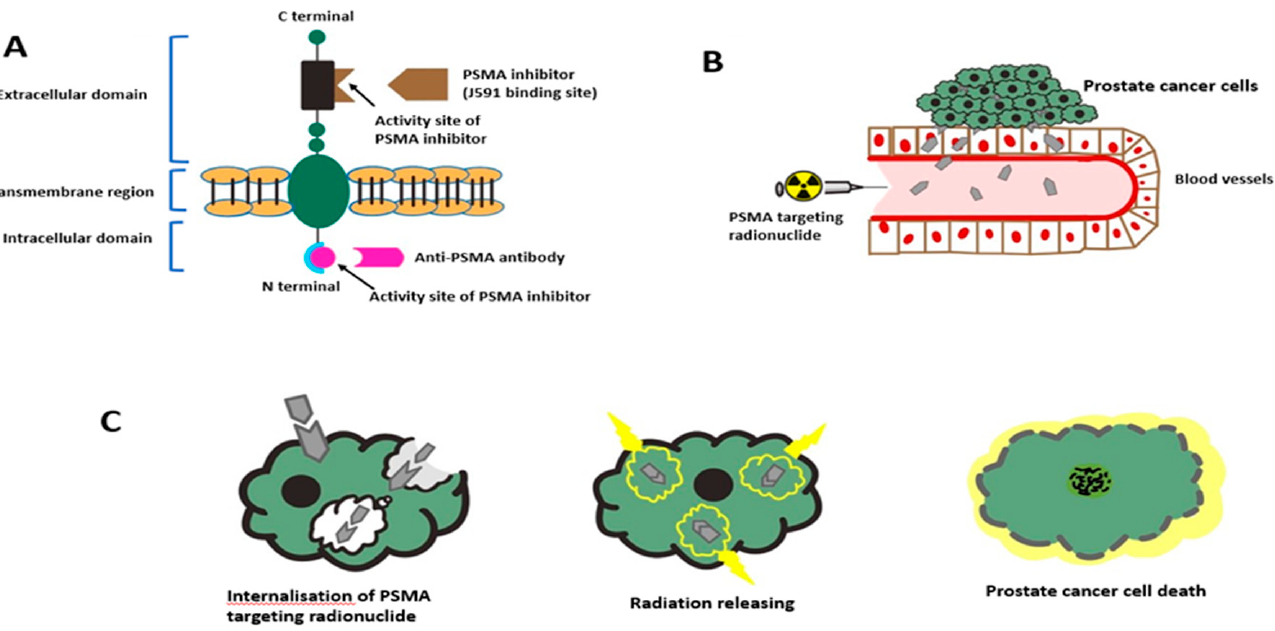
Figure 1. Schematic representation of PSMA molecular structure and effect of PSMA targeting radionuclide therapy to manage a PCa patient. ( A ) PSMA molecule has 3 domains; intracellular, trans- membrane, and the large extracellular portions. ( B ) PSMA targeting radionuclide is injected into the bloodstream, the PSMA targeting radionuclide binds to the activity site on the prostate cancer cells. ( C ) After binding to the activity site on the cell membrane, the PSMA targeting radionuclide is in-